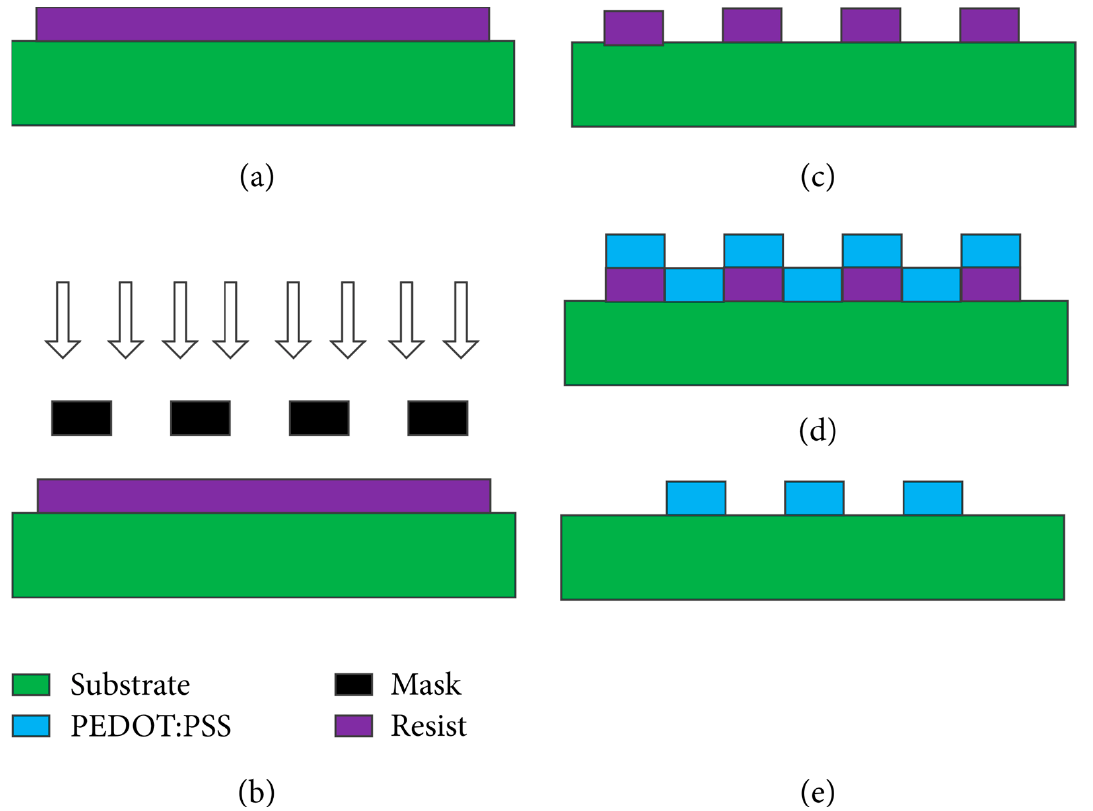
Figure 2. Schematic processes of photolithographic patterning of PEDOT:PSS. Photoresist was first spin-coated ( a ) and patterned ( b ), ( c ) on a substrate. Then, PEDOT:PSS was subsequently deposited ( d ). After lift-off of left resist, PEDOT:PSS patterns were left on the substrate ( e ). Reproduced from Ref. [28] under the Creative Commons Attribution 4.0 International (CC BY 4.0) License).